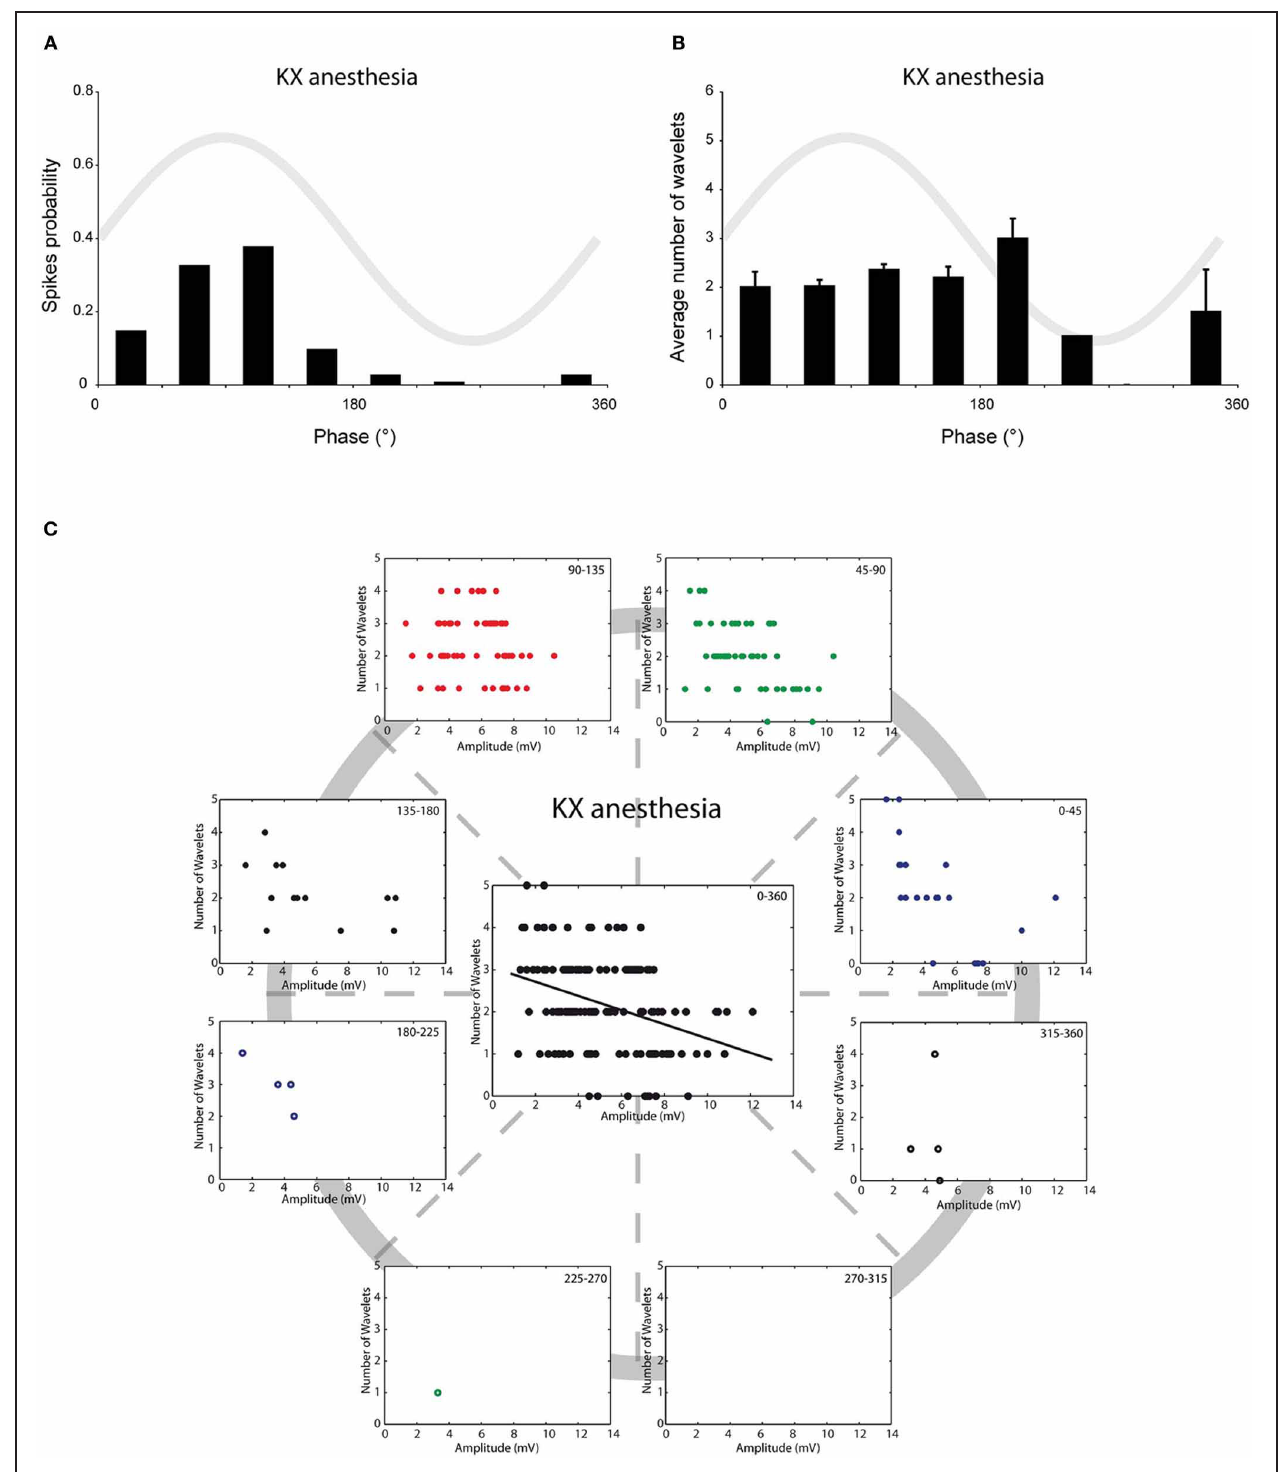
FIGURE 2 | Burst size of olivary wavelets and SSTOs under KX anaesthesia. (A) The occurrence of spontaneous spikes (spike probability) in relation to the phase of the SSTO obtained from olivary neurons recorded under KX anaesthesia ( n = 155). (B) Average number of wavelets on the ADP of spontaneous spikes in relation to the phase of the SSTO obtained from olivary neurons recorded under KX anaesthesia ( n = 155). (C) Relationship